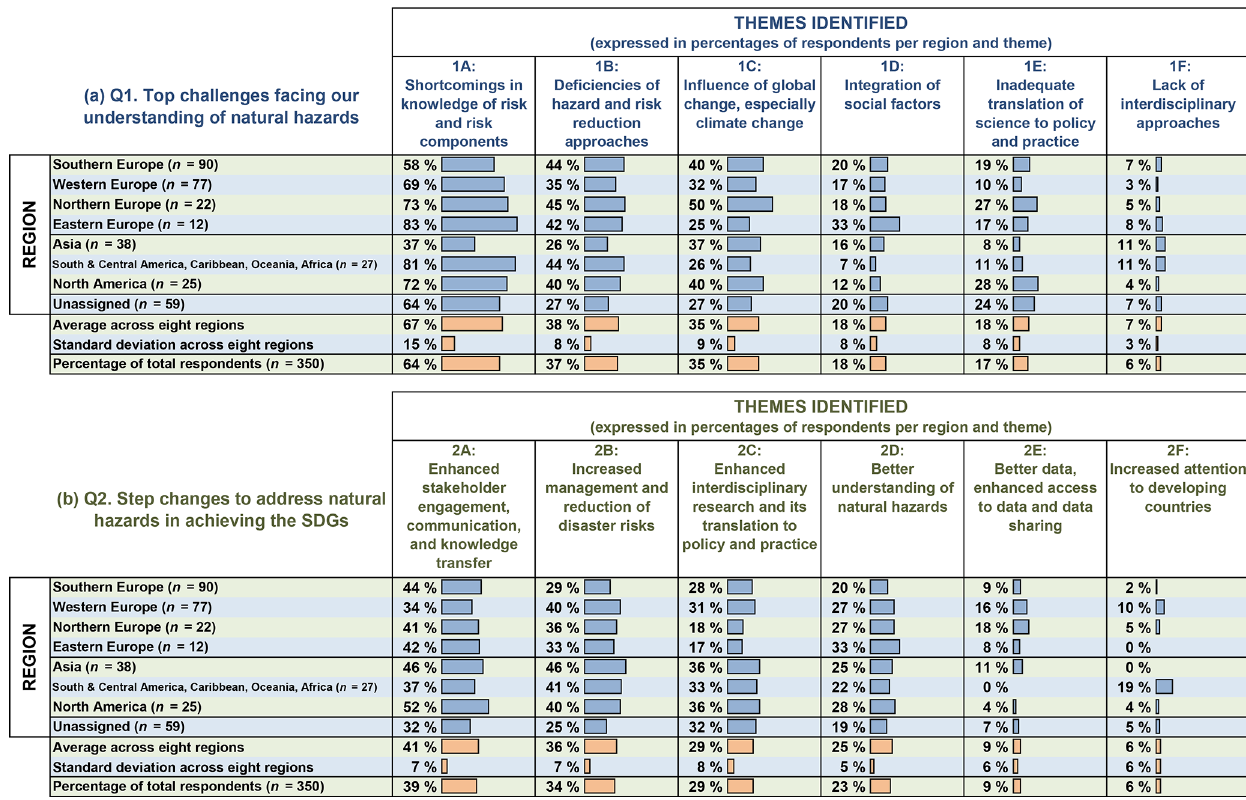
Table 2. Regional difference in responses of 350 natural hazard community members to the two NHESS survey questions: (a) top challenges facing our understanding of natural hazards and (b) step changes to address natural hazards in achieving the Sustainable Development Goals (SDGs). Numbers given are expressed as the percentage of the total number of respondents in a region whose answers were classified under a specific